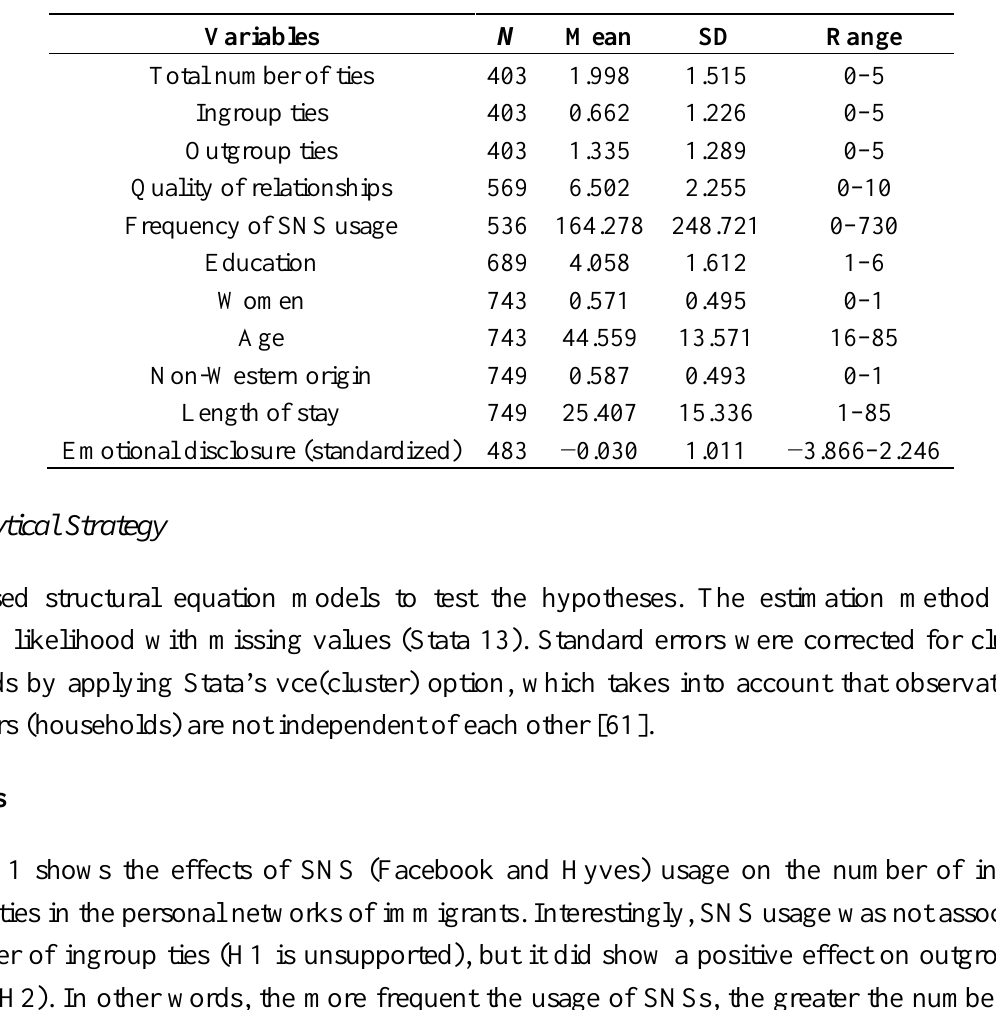
Table 1. Descriptive statistics. SNS, social network